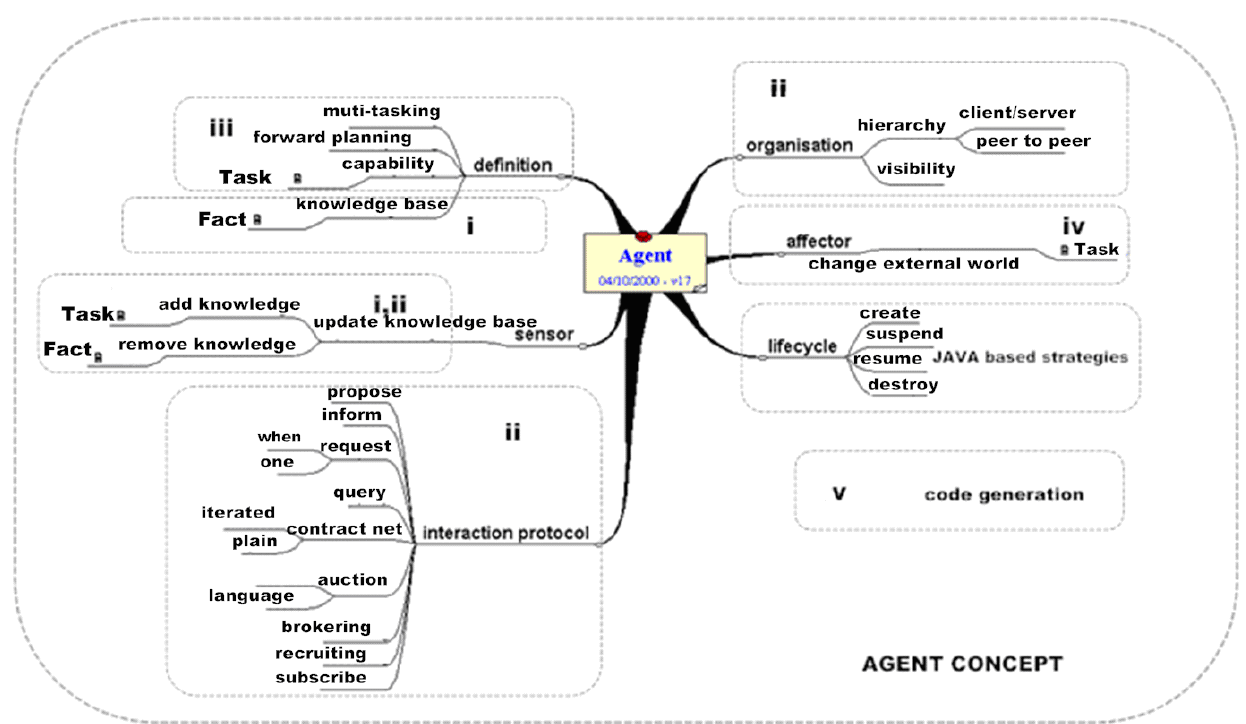
Figure 3. Agent concept and steps of its